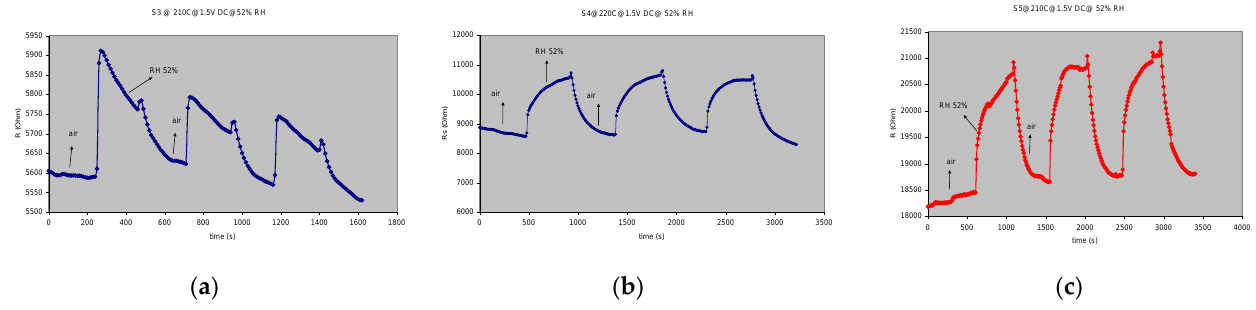
Figure 4. The response/recovery characteristics for 3 successive injections of 52% RH at corresponding T w : ( a ) S3 sensor, T w = 210 °C; ( b ) S4 sensor T w = 220 °C; ( c ) S5 sensor, T w = 210 °C.